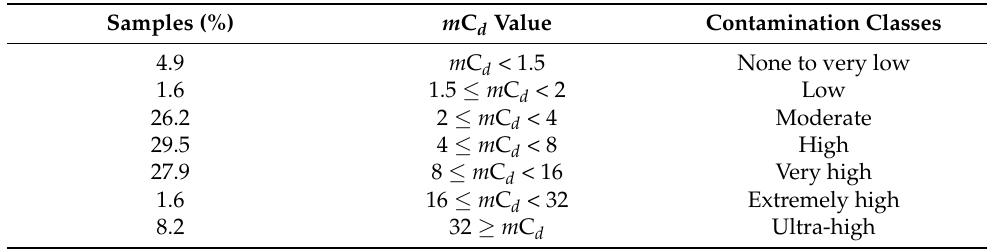
Table 3. Percentage distribution of soil samples according to the degree of contamination defined by